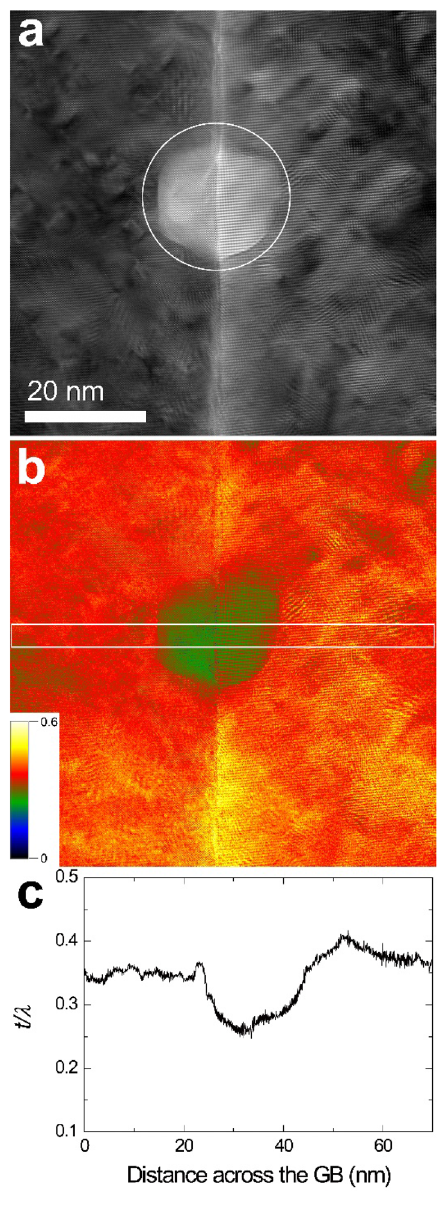
Figure 6. ( a ) EFTEM image (unfiltered) obtained from a beam irradiated area at 25 nm for 2 min 8 s and ( b ) a corresponding thickness map. ( c ) Line profile of relative thickness for the rectangular area shown in ( b